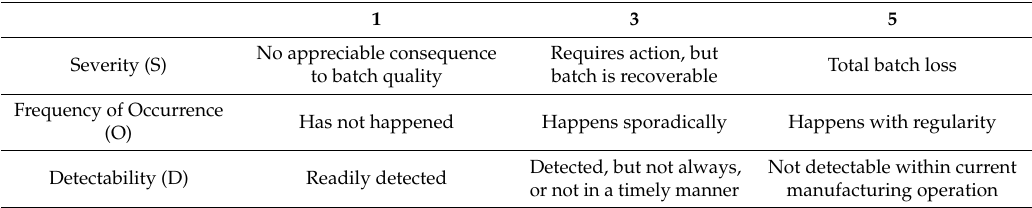
Table 2. Descriptions for upper, middle, and lower risk priority number values for the categories of severity, frequency of occurrence, and detectability.